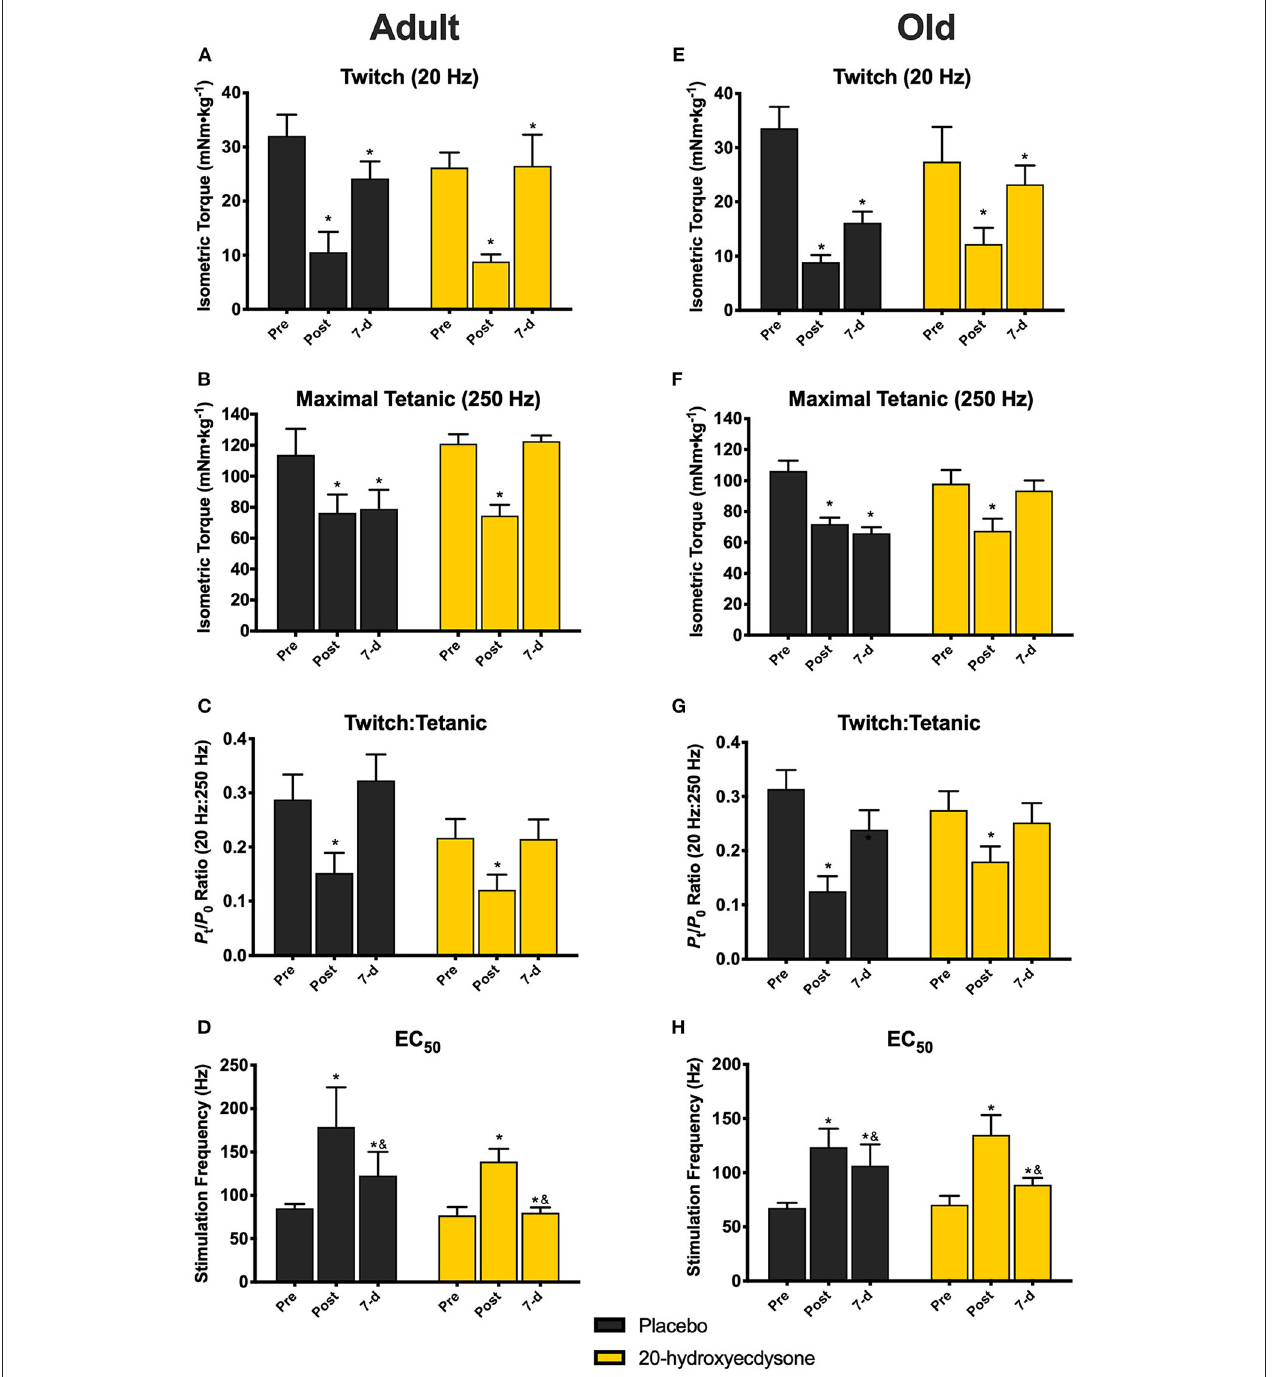
FIGURE 3 | Isometric twitch torque, maximal tetanic torque, twitch:tetanic ratio, and EC 50 of the anterior crural muscles in Adult and Old mice at the pre-injury, immediately post-injury, and 7-day recovery time points. Analysis revealed significant reductions in twitch torque (20Hz; A,E ) in all groups immediately after (Post) and at 7 days (7-d) following the eccentric contraction-induced muscle damage protocol, regardless of treatment condition. Maximal tetanic torque (250Hz) was also significantly reduced in both adult (B) and old mice (F) Post eccentric damage, compared to Pre, regardless of treatment condition. Only the 20E-treated adult and old mice fully recovered maximal tetanic torque to pre-injury levels by 7-d. Twitch:Tetanic ratio was significantly reduced at Post in both adult (C) and old mice (G) , regardless of treatment condition, compared to Pre, but Twitch:Tetanic recovered by 7-d. EC 50 was significantly higher in all age and treatment groups at Post, but EC 50 at 7-d was still significantly different than Post and Pre (D,H) . Values represent mean ± SEM. PLA, placebo; 20E, 20-hydroxyecdysone; EC 50 , stimulation frequency required to elicit 50% of maximal tetanic torque. * significantly different than Pre within the same group ( p < 0.05); & significantly different than Post within the same group ( p <